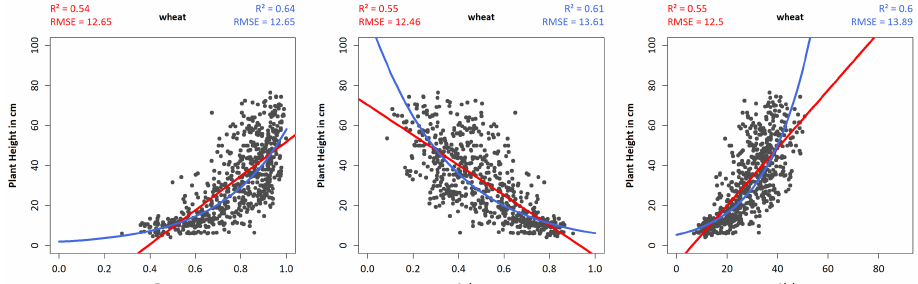
Figure 11. Scatter plots of entropy, anisotropy, and alpha related to the plant height of wheat for BBCH stages 21–49: the regression lines, R 2 , and RMSE are shown in red (linear regression) and blue (exponential regression).